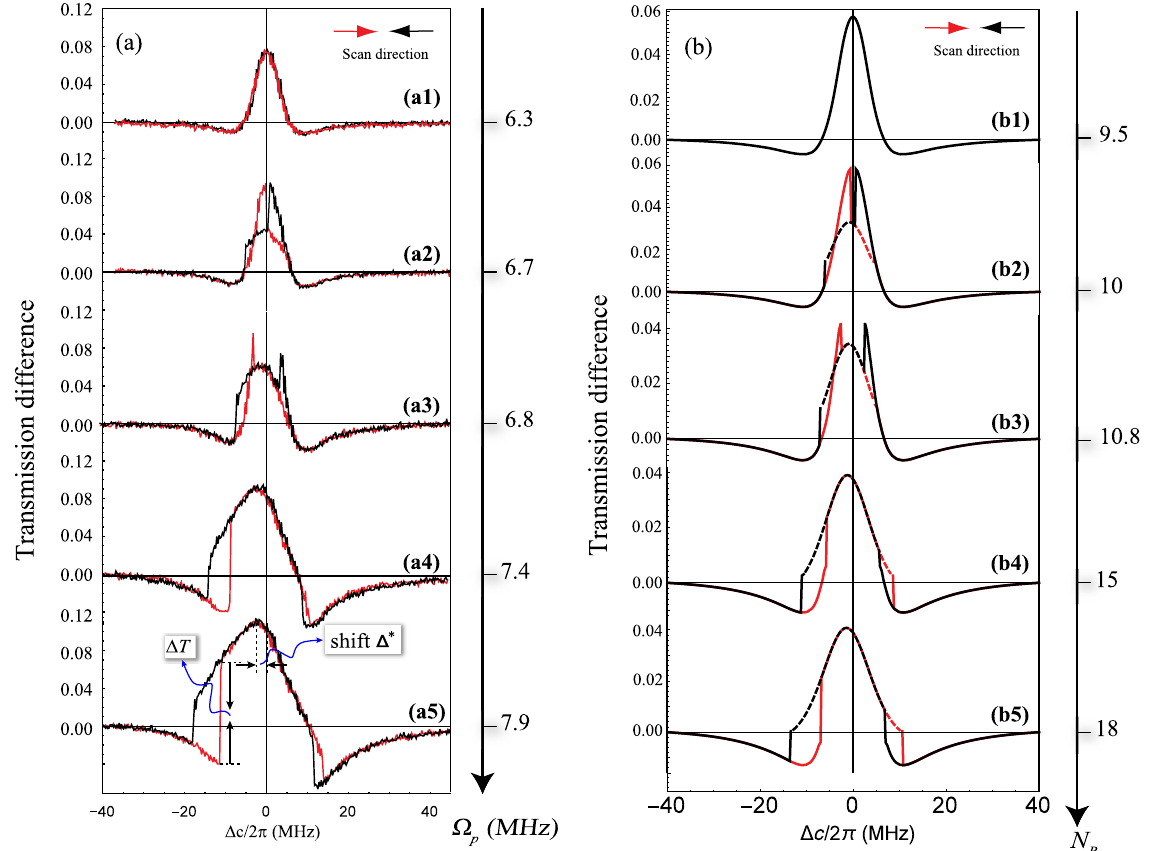
FIG. 3. Observation of optical bistability induced by a nonequilibrium phase transition in EIT transmission spectra. (a) Transmission difference between probe and reference beams normalized by the reference field (negative values indicate stronger absorption compared to the reference) as Δ is scanned from red to blue detuning (red) and vice versa (black) for increasing probe Rabi frequencies c Ω = 2 π ¼ 6 . 3 (a1), 6.7 (a2), 6.8 (a3), 7.4 (a4), and 7.9 MHz (a5). Panel (a5) shows the definitions of the transmission difference between p the states at the point of the phase transition Δ T and the spectral shift Δ (cid:3) referred to subsequently. (b) Simulated transmission spectra for 9 . 5 (b1), 10.0 (b2), 10.8 (b3), 15.0 (b4), and 18.0 (b5), where N increasing Rydberg densities with N r ¼ of Rydberg atoms. The dashed line in panel (b) shows where the system is found in the strongly interacting I